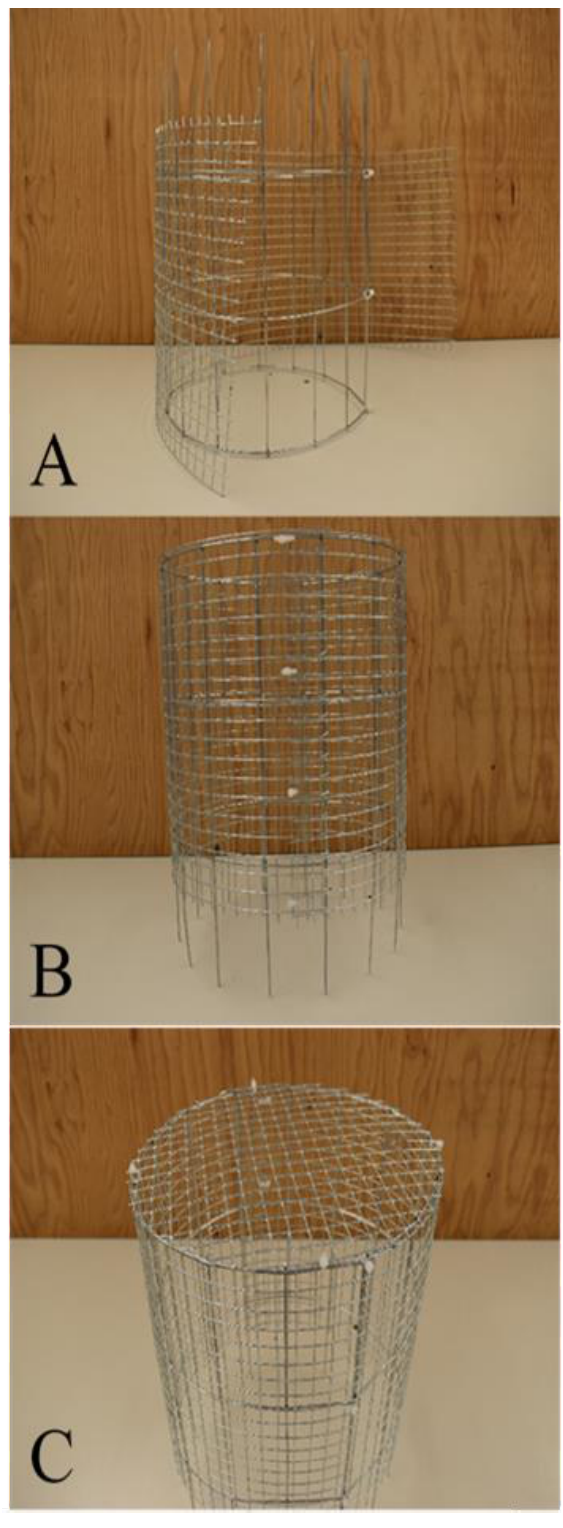
Figure 3. Attachment of hardware cloth to internal frame structure. (A) Completed exlosure frame with hardware cloth unattached, (B) Hardware cloth attached to the side of exclosure, (C) Hardware cloth attached to the top of